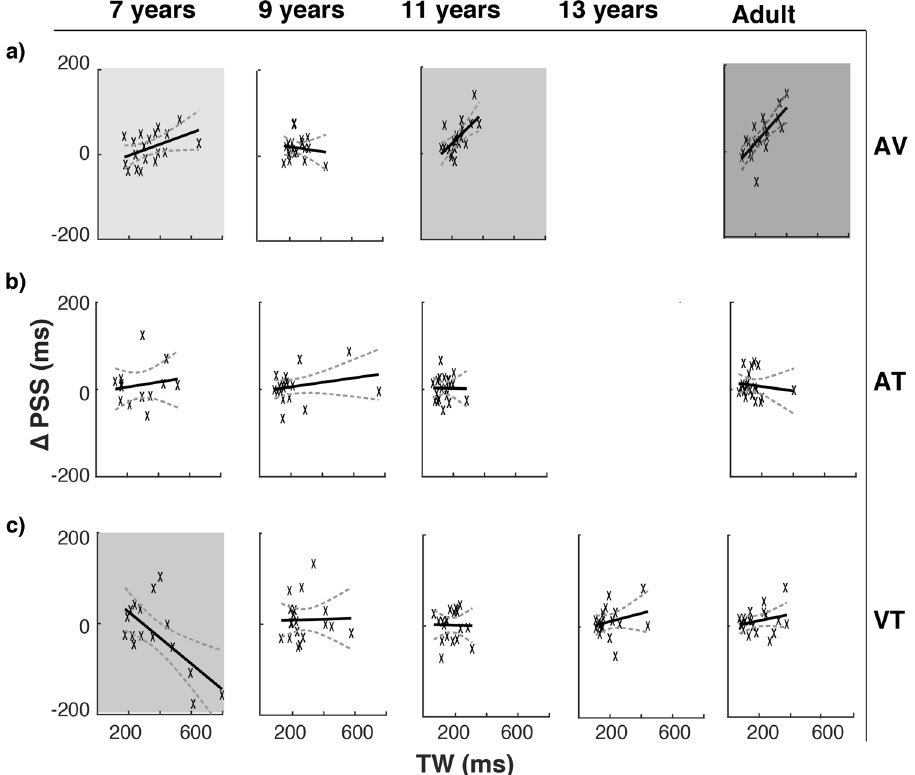
Figure 3. The relation between PSS shifts and the widths of the temporal window of simultaneity for ( a ) audio– visual, ( b ) audio–tactile and ( c ) visual-tactile pairings. Wider audio–visual windows are typically accompanied by larger PSS shifts 25 , but this relation becomes reliably significant only at 11 years of age and adults. Audio- tactile pairings do not follow a similar relation, demonstrating only a reduced variance from 9 years of age onwards. Similarly, visual–tactile pairings showed a reduced variance from 9 years of age onwards. At 7 years of age (shaded bottom–left panel), visual–tactile simultaneity judgments demonstrated a negative correlation, which was found to be statistically significant. Shaded areas represent significance on at least one of the statistical tests (i.e., linear regression analyses and/or bootstrap hypothesis tests; lightest grey: smallest p < .05, mid grey: smallest p < .01, darkest grey: smallest p < .001).